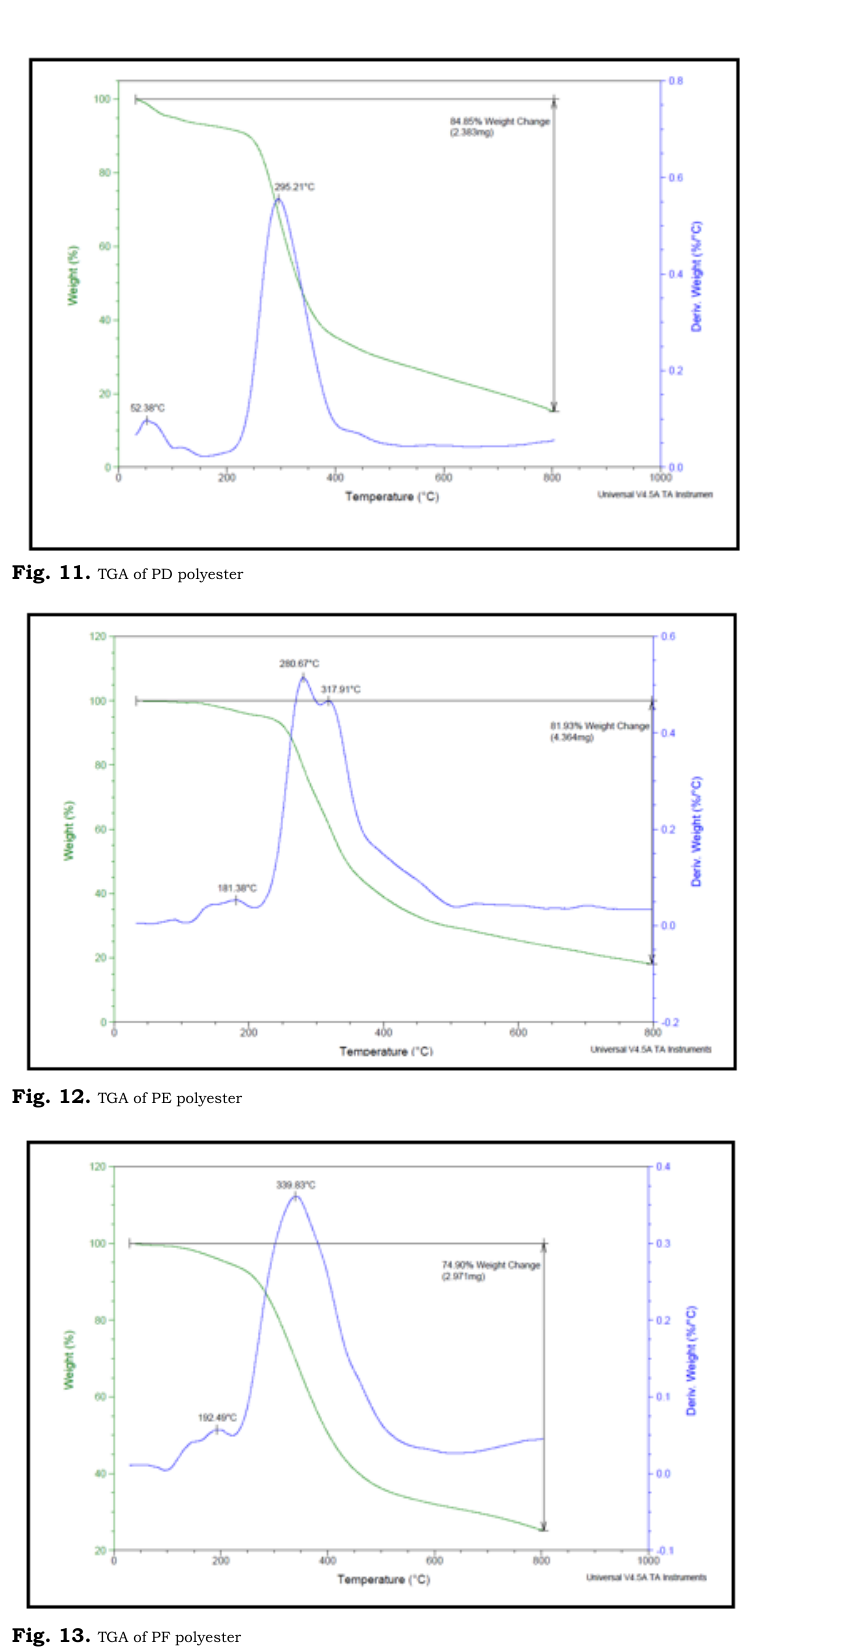
Fig. 13. TGA of PF